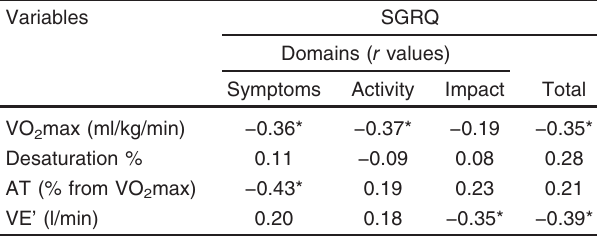
Table 3 Correlation between cardiopulmonary exercise testing and Saint George Respiratory Questionnaire Variables